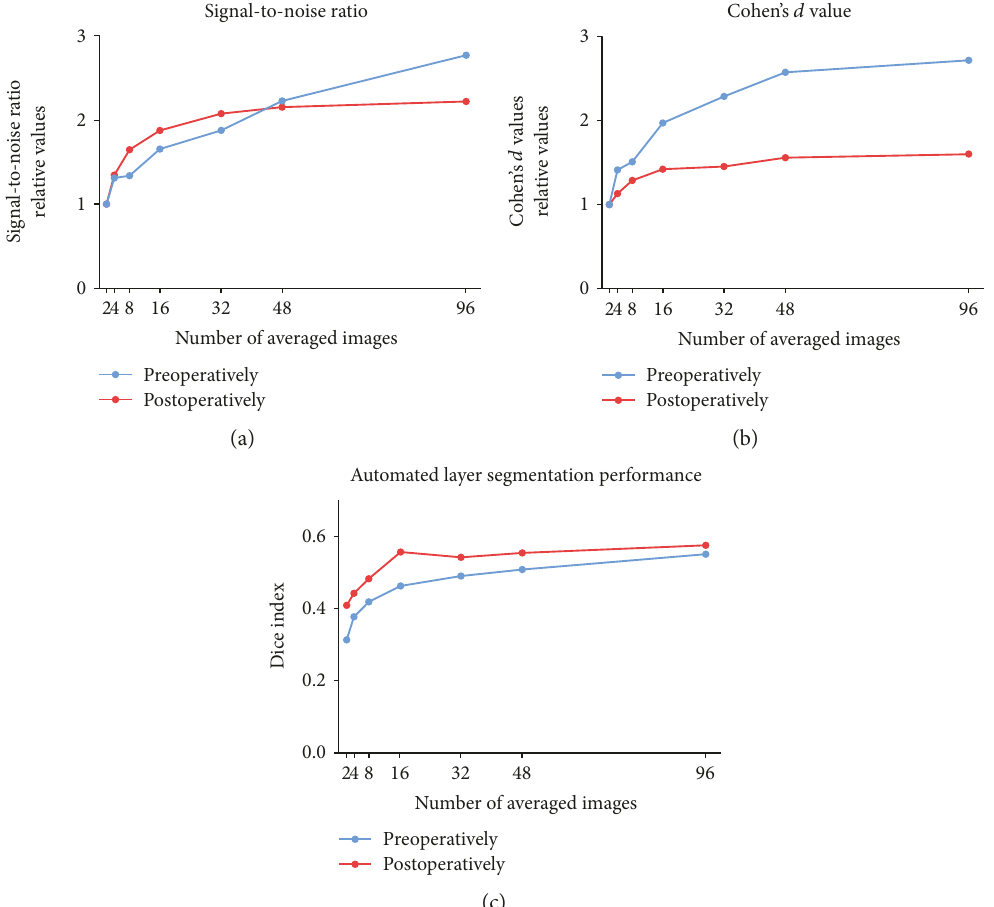
Figure 3: Quantitative measures of image quality. The graphs show signal-to-noise ratio (SNR; (a)), the Cohen ’ s d value (b), and intraretinal layer segmentation performance (c). SNR and Cohen ’ s d are computed relative to the baseline at two averaged frames. The SNR compares the level of a desired signal in the image to the level of noise. Cohen ’ s d value describes the dissimilarity of individual retinal layers based on their grey values and is inversely proportional to the overlap of distributions. It is computed for two neighboring layers. The ability to di ff erentiate between the individual retinal layers based on their appearance was further assessed by measuring the performance of an automated computer algorithm on correctly segmenting each layer based on pixel classi fi cation. Cohen ’ s d value and the automated layer segmentation performance are demonstrated as relative values. Results are shown as mean for each averaging frame increment, separately for pre- and postoperative results overall patients and all